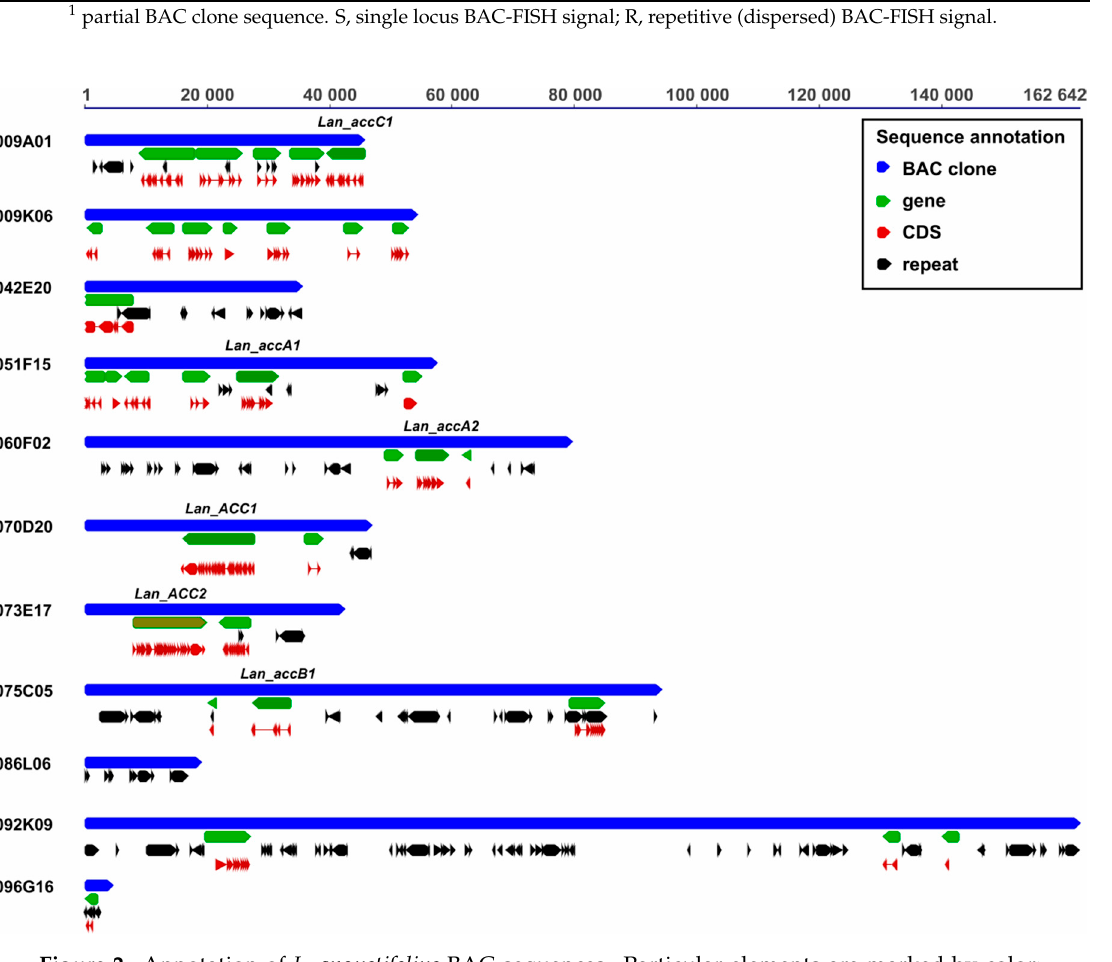
Table 4. Characterization of BAC clone sequences.